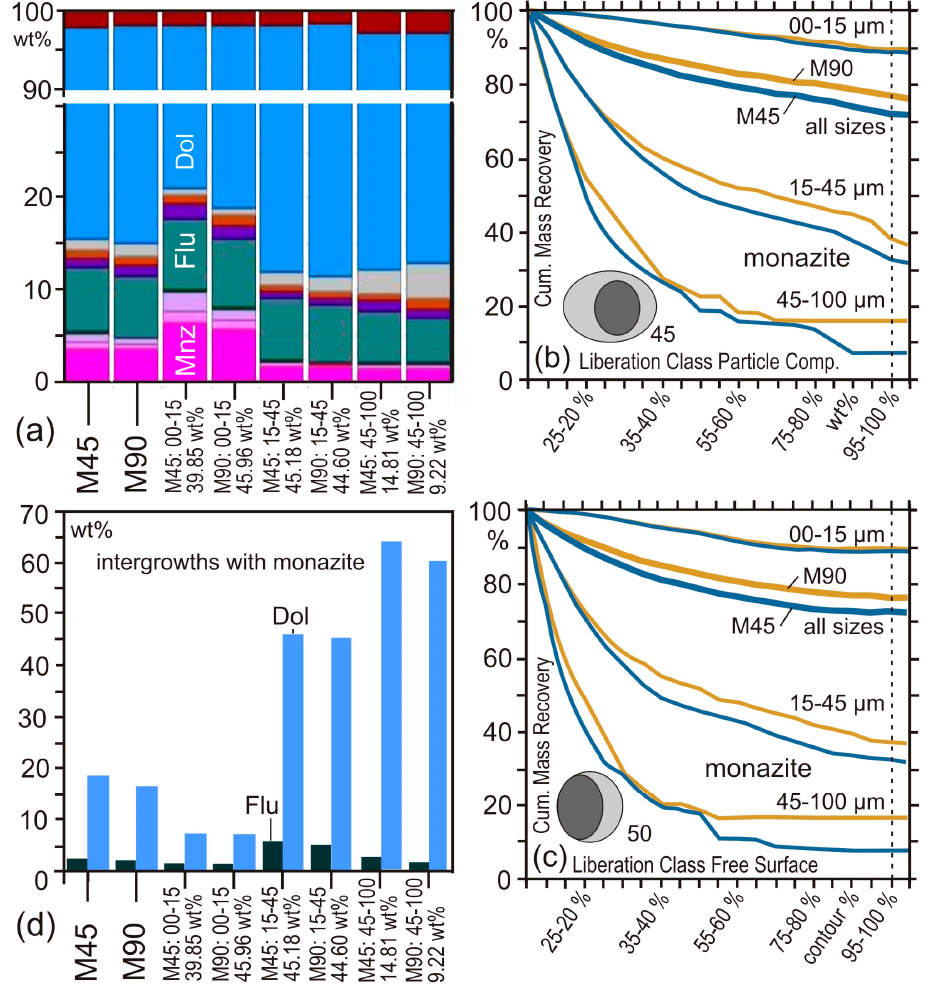
Figure 3. Results of comminution tests of REE carbonatite ore with 45 and 90 min length of time. ( a ) Modal mineralogy (in wt %, y-axis) of complete samples and of particle size classes by virtual sieving with the filter routine of equivalent circle (EC) diameter (see text). Proportion of the corresponding particle size class in wt % (x-axis). Dolomite (Dol); fluorite (Flu) and REE-P-monazite (Mnz) are labelled. ( b ) Mineral liberation of REE-P-monazite in terms of proportion in wt % of particle composition. Inset sketch displays the liberation class particle composition of 45 wt % REE-P-monazite in a schematic view. ( c ) Mineral liberation of REE-P-monazite in terms of proportion in contour% of free surface. Inset sketch displays the liberation class free surface of 50% REE-P-monazite in a schematic view. ( d ) Presentation of the intergrowths of non-liberated REE-P-monazite with fluorite (Flu) and dolomite (Dol). Proportions of fluorite and dolomite in wt % in the complete samples and in particle size fractions by virtual sieving with the filter routine EC diameter (see text).